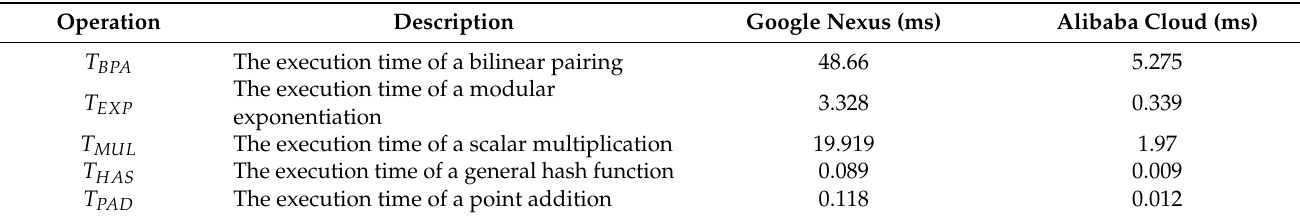
Table 3. Execution time of basic operations.